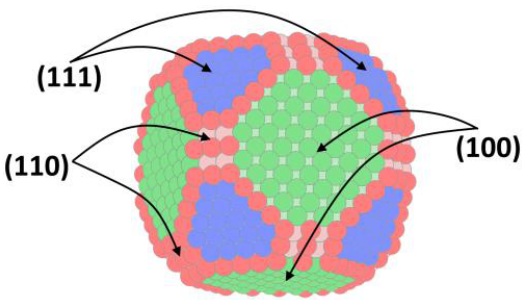
Figure 4. Crystal structure of a platinum nanoparticle [52]. In the potential region below the A1 peak, there is also a region of molecular hydrogen evolution. The beginning of this region on the CV corresponds to the bending of the polarization curve at about 0 V relative to the reversible hydrogen electrode (see Figure 3). For accurate measurement of the ESA, it is important to exclude this region; therefore, the use of the adsorption isotherm makes it possible to determine the beginning of the hydrogen evolution process with a higher degree of accuracy [54]. Figure 5 shows the contributions of the peaks to the ESA as well as the values of the adsorption energies corresponding to the peaks. The parameters of the peaks are close in value, but there is a greater deviation between the parameters of Pt black and Pt/RGO. In the case of the ESA, the Pt black sample has the lowest A1 and A2 peak values but the highest A3 peak value. Since with an increase in the particle size the percentage of sites with the lattice of type 110, as well as edges and corners on their surface, considerably decreases, the contribution of structures of this type to the hydrogen adsorption peak is less for larger particles than for smaller ones [55,56].